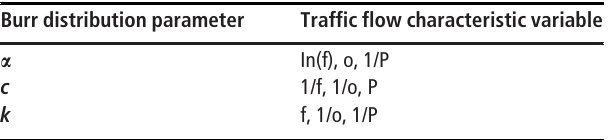
Table 3 Selected traf fi c fl ow characteristics variables Burr distribution parameter